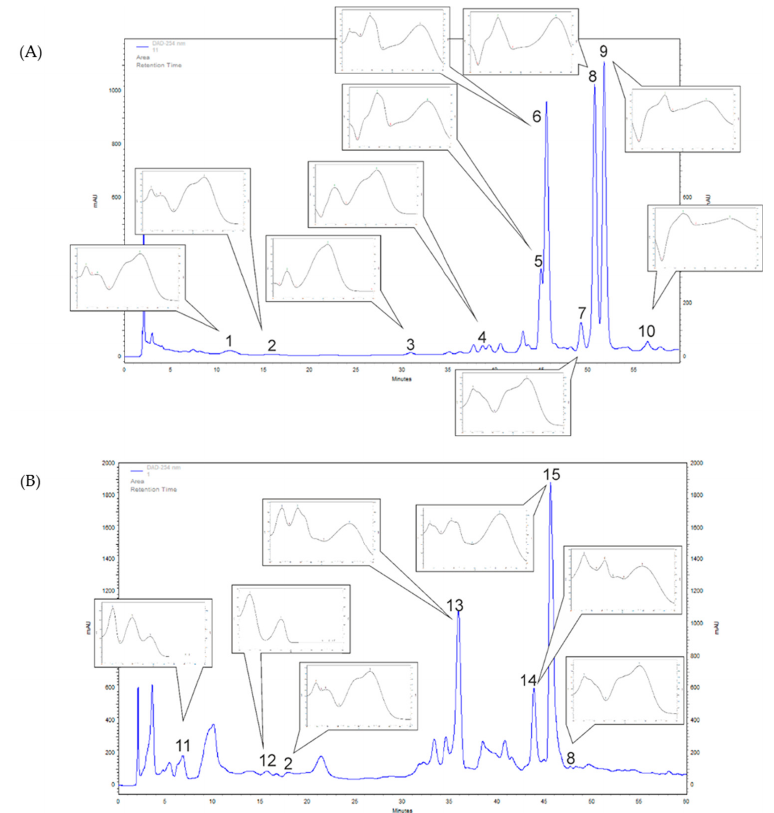
Figure 1. Samples of high performance liquid chromatography diode array (HPLC-DAD) separation ( λ = 254 nm) of the extracts of: (A) F. alnus and (B) P. harmala (1—chlorogenic acid, 2—caffeic acid, 3—p-coumaric acid, 4—ferulic acid, 5—rutoside, 6—unknown compound, 7—quercetin, 8—rosmarinic acid, 9—quercitrin,